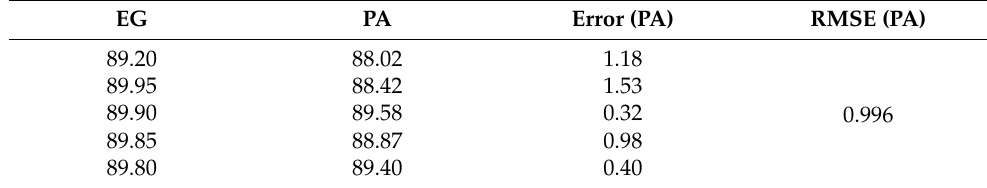
Figure 11. Measured angle using proposed algorithm (PA) with and without external noise. Table 9. RMSE ( ° ) of the joint angle (external noise added).